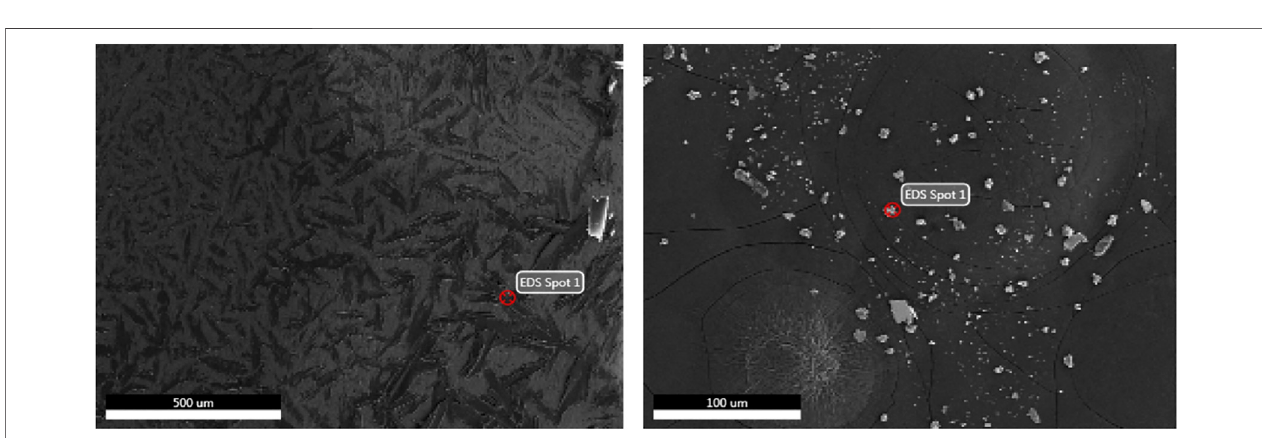
FIGURE 3 | SEM images of the schistose crystal (left) and scattered particles (right) in the mixed crystal of DHB and 30 cP hydroxyl silicone oil.